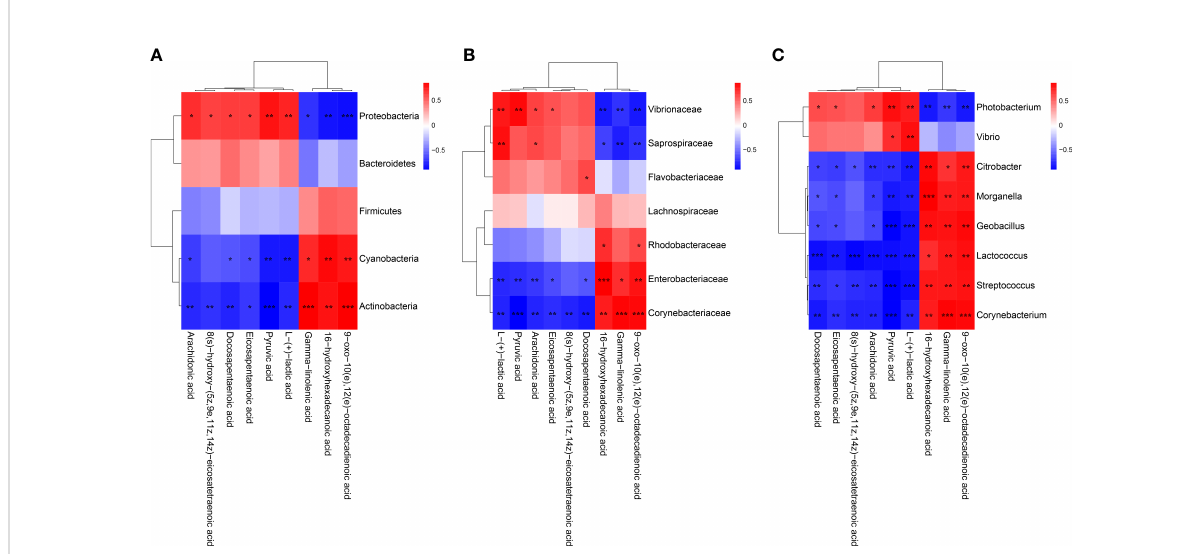
FIGURE 10 Heap maps of correlation between the nine marker DMs and the hosts intestinal microbial. (A) Phylum classi fi cation level. (B) Family classi fi cation level. (C) Genus classi fi cation level. Red indicateds a positive coreelation, and blue represents a negative correlation. * Indicates a signi fi cant difference (* p < 0.05; ** p < 0.01; *** p <